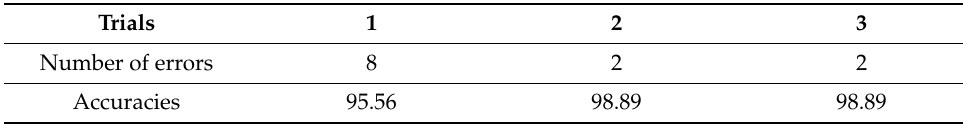
Table 4. Number of errors and accuracies through the